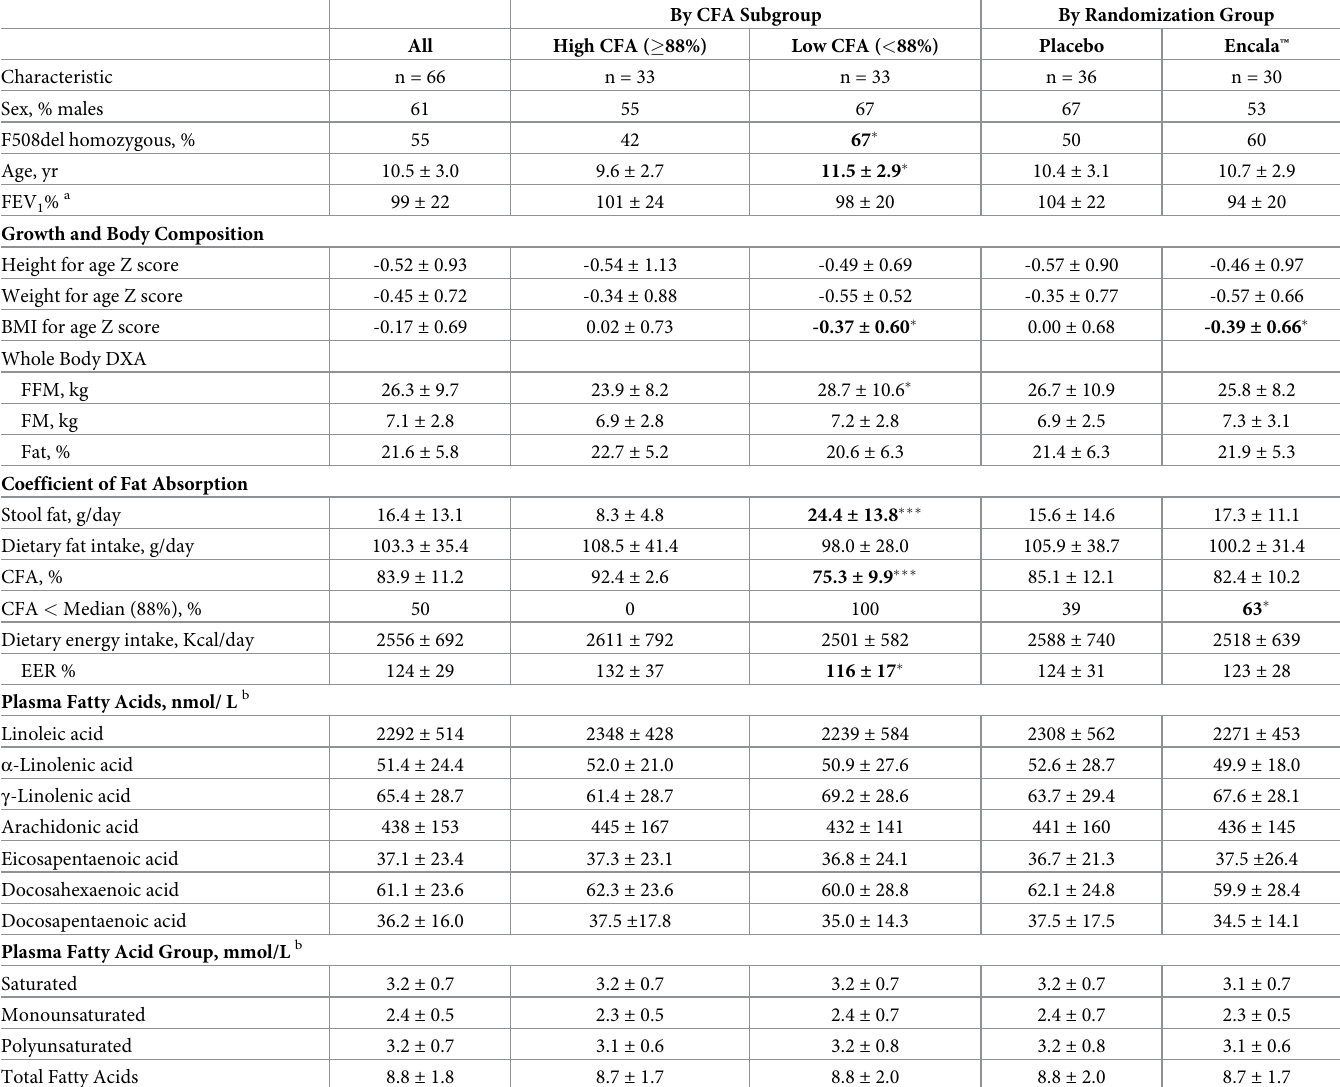
Table 1. Characteristics at baseline for CFA subgroups and for randomization groups.